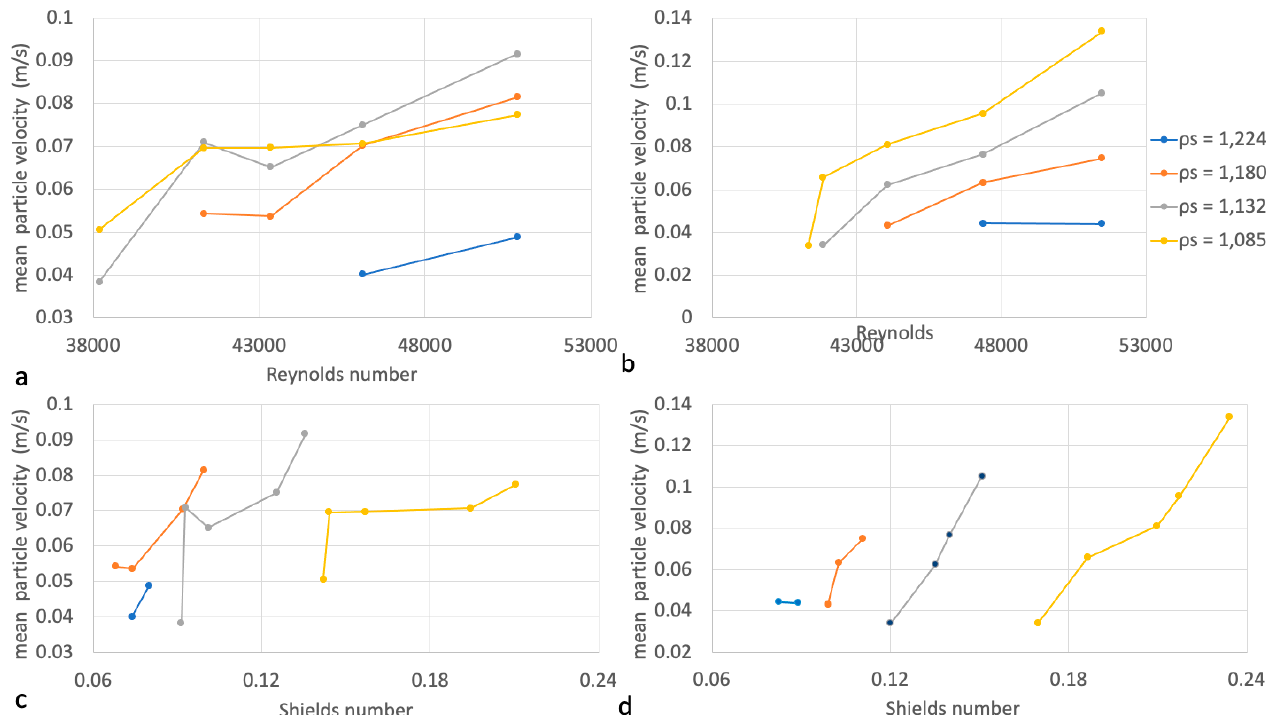
Figure 16. Mean instrumented particle velocity, for different solid densities: ( a ) against Reynolds number, for bed surface A, ( b ) against Reynolds number, for bed surface B, ( c ) against Reynolds number, for bed surface A, and ( d ) against Reynolds number, for bed surface B.